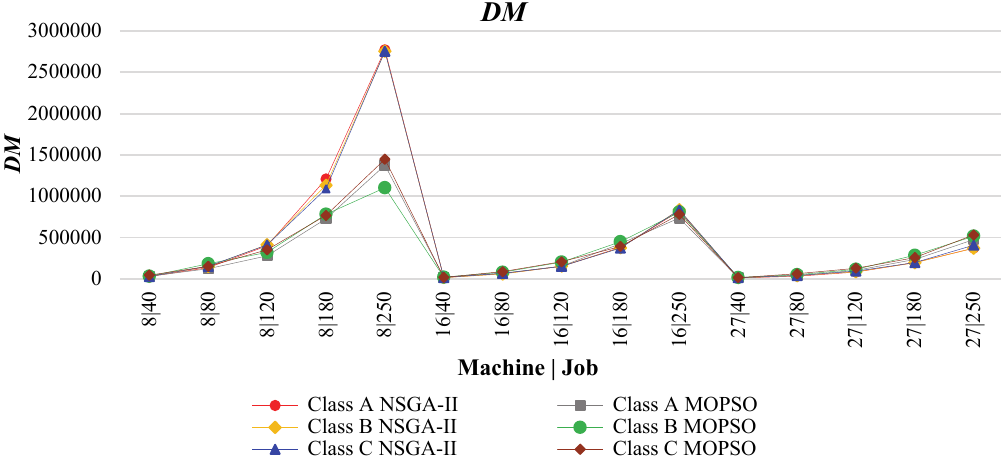
Fig. 19 DM criterion for the two algorithms in the medium and large scale sample